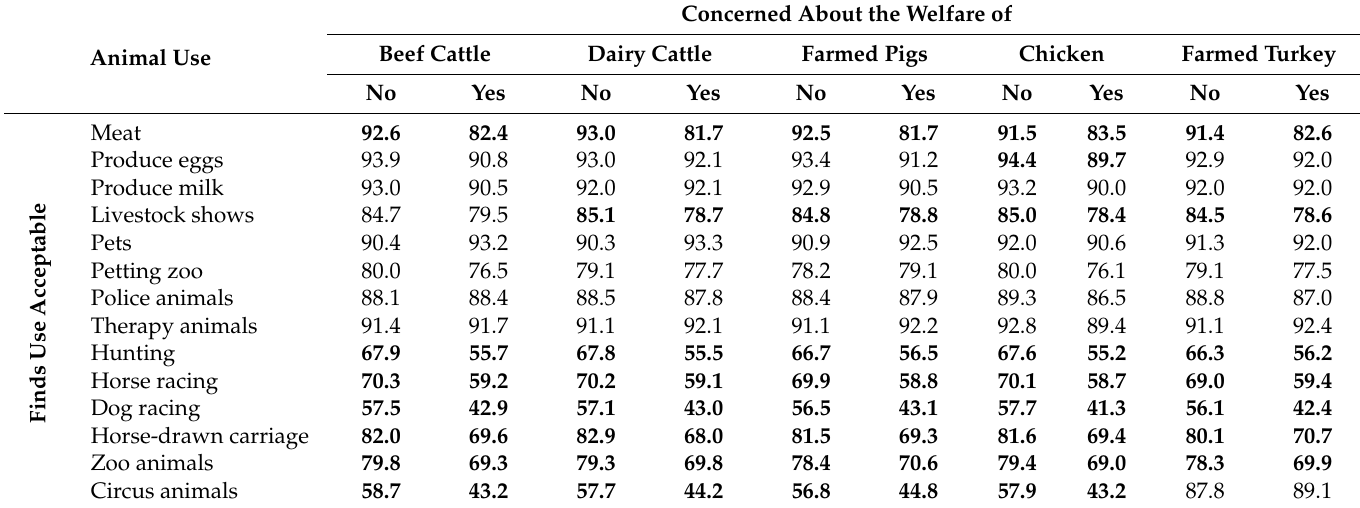
Table 8. Cross tabulations between concern for the welfare of farmed animals and acceptance of animal uses.